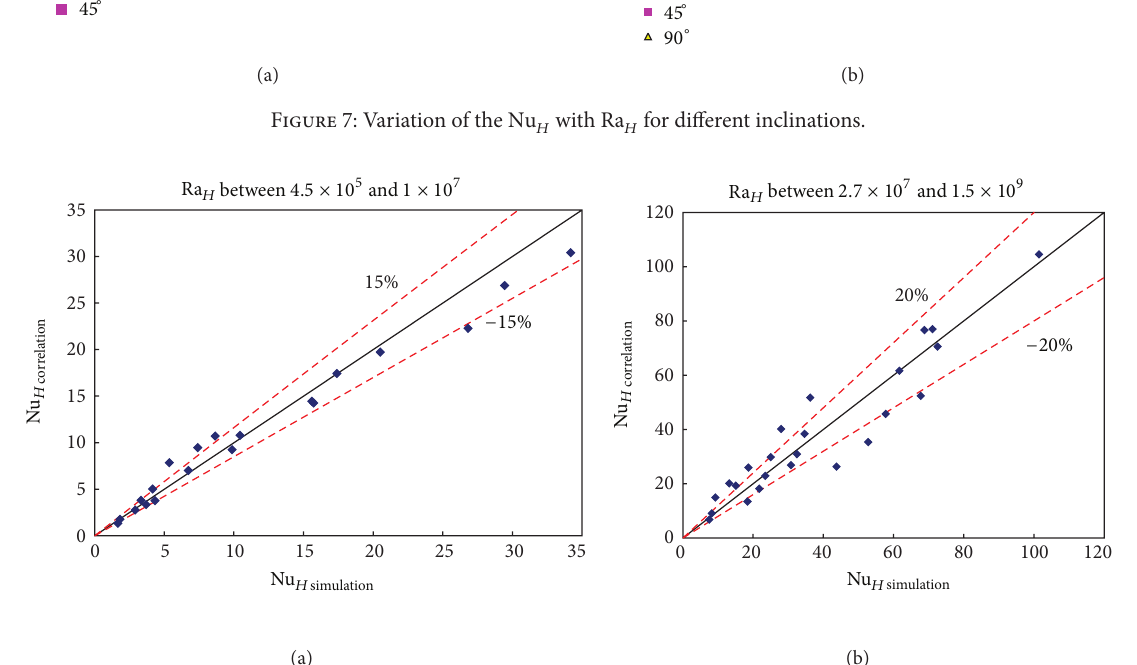
Figure 8: Parity plots of Nu 𝐻